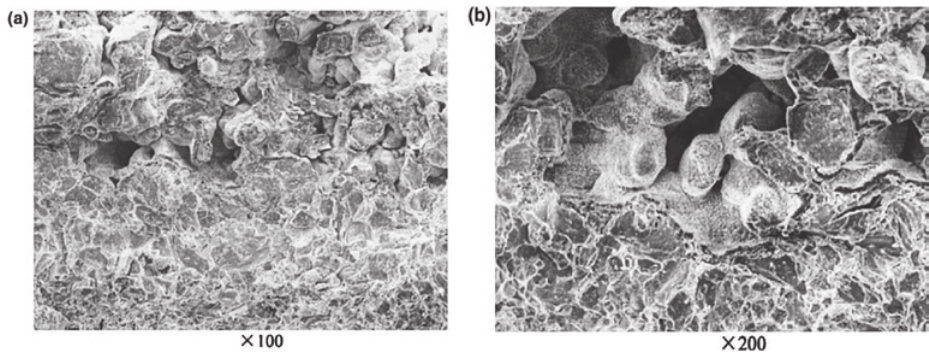
Fig. 8: Globular grains due to melting [21].